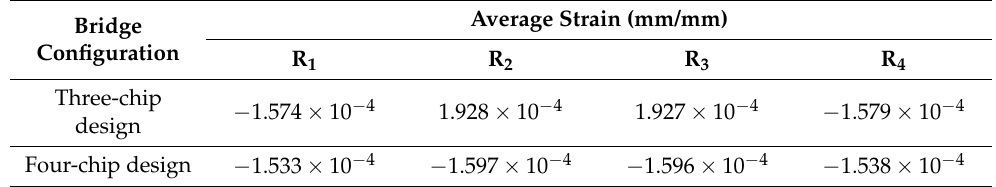
Table 1. Average strain for three-chip and four-chip designs.